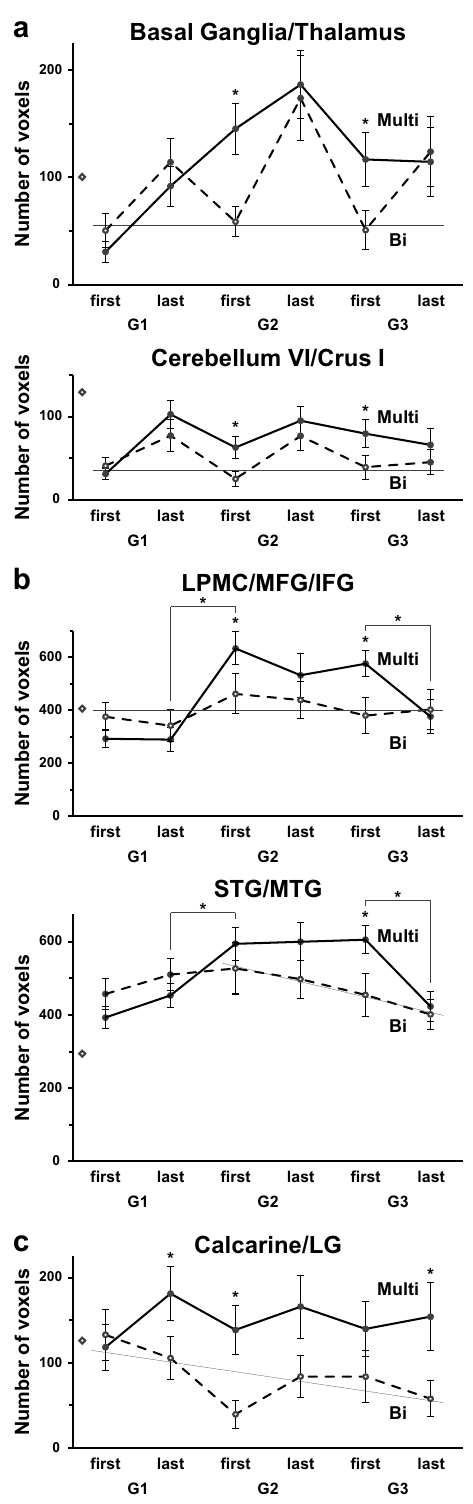
Figure 6. Temporal patterns of activations for the Multi group distinct from those for the Bi group. Within each ROI, a number of activated voxels (estimated by the contrast of Sentence–Lexical list, uncorrected p < 0.001 for each participant) was counted and shown for each run. The number of voxels for a ROI in each hemisphere was treated as independent samples. For each panel, a thin fitting line for selected open points of the Bi group is shown, in accordance with individual temporal patterns of activations. The rhombus symbols on the ordinate denote 10% voxels within each ROI, where the scale of each graph was normalized with this fixed ratio. ( a ) The number of voxels in the basal ganglia/thalamus and in the cerebellum. ( b ) The number of voxels in the lateral premotor cortex/ middle/inferior frontal gyrus (LPMC/MFG/IFG) and in the superior/middle temporal gyri (STG/MTG), i.e., the language-related regions and right homologs. ( c ) The number of voxels in the calcarine/lingual gyrus (calcarine/LG). Error bars indicate SEM. * p < 0.05. These images were created using Microsoft Excel 2013 and Adobe Illustrator (as